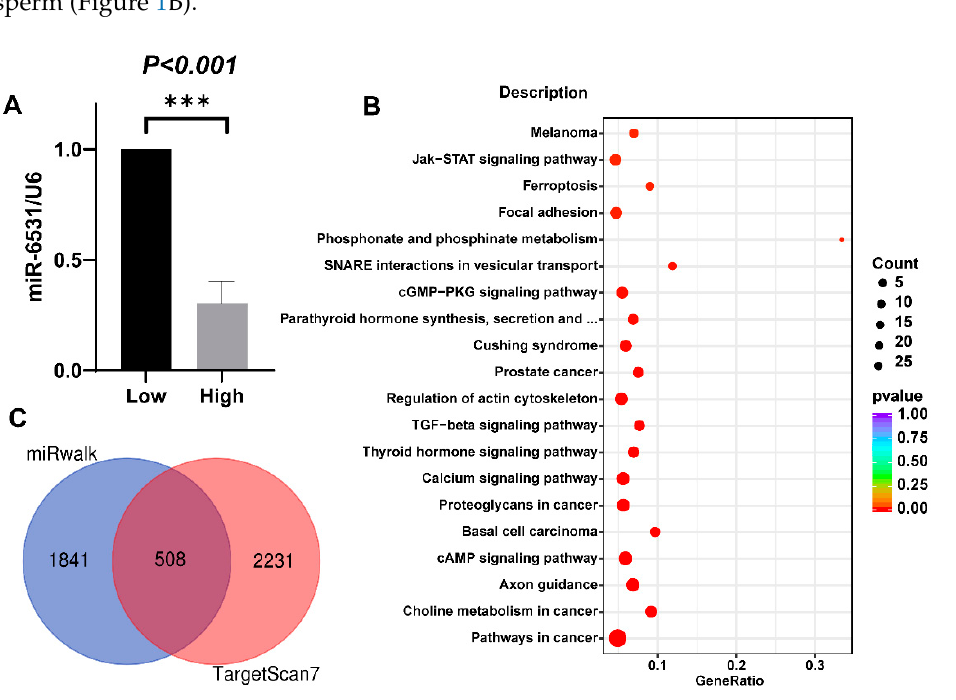
Figure 1. The predicted targets of bta-miR-6531 are mainly involved in the calcium signaling pathway and the cAMP signaling pathway. ( A ) The expression of miR-6531 in different motility sperms; ( B ) Targets of bta-miR-6531 were predicted using two miRNA databases. ( C ) The KEGG pathway enrichment of the 508 shared targets ( ** * p < 0.001 ).